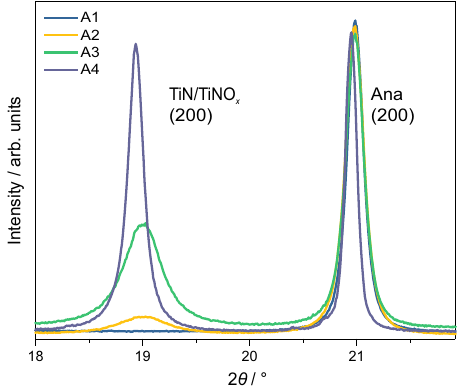
Fig. 6 SXRD patterns of anatase with different N contents. SXPD patterns of anatase samples A0 – A3, as well as a high-temperature sample A4 prepared at 750 °C. Intensities normalised due to different data-collection